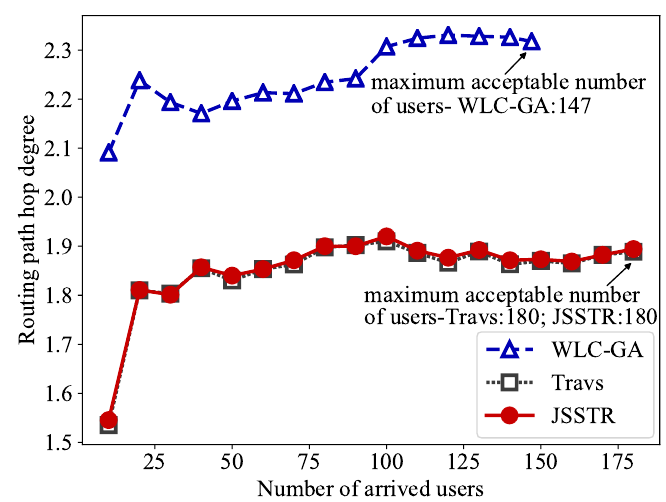
Figure 5. Routing path hop degree comparison for JSSTR, Travs and